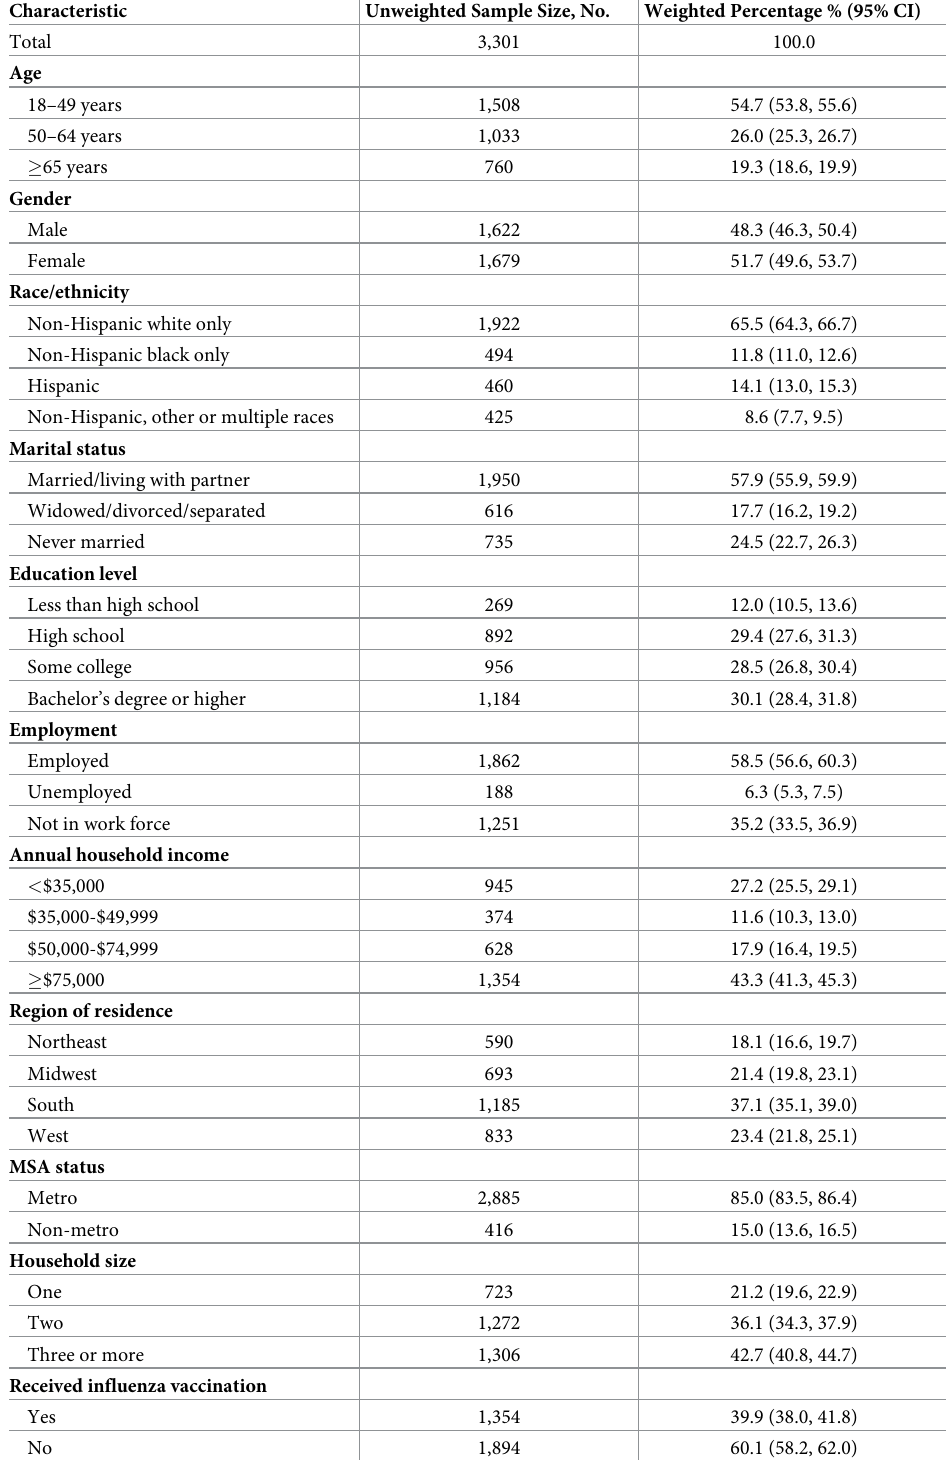
Table 1. Sociodemographic characteristics among adults aged (cid:21) 18 years–United States, National Internet Flu Survey